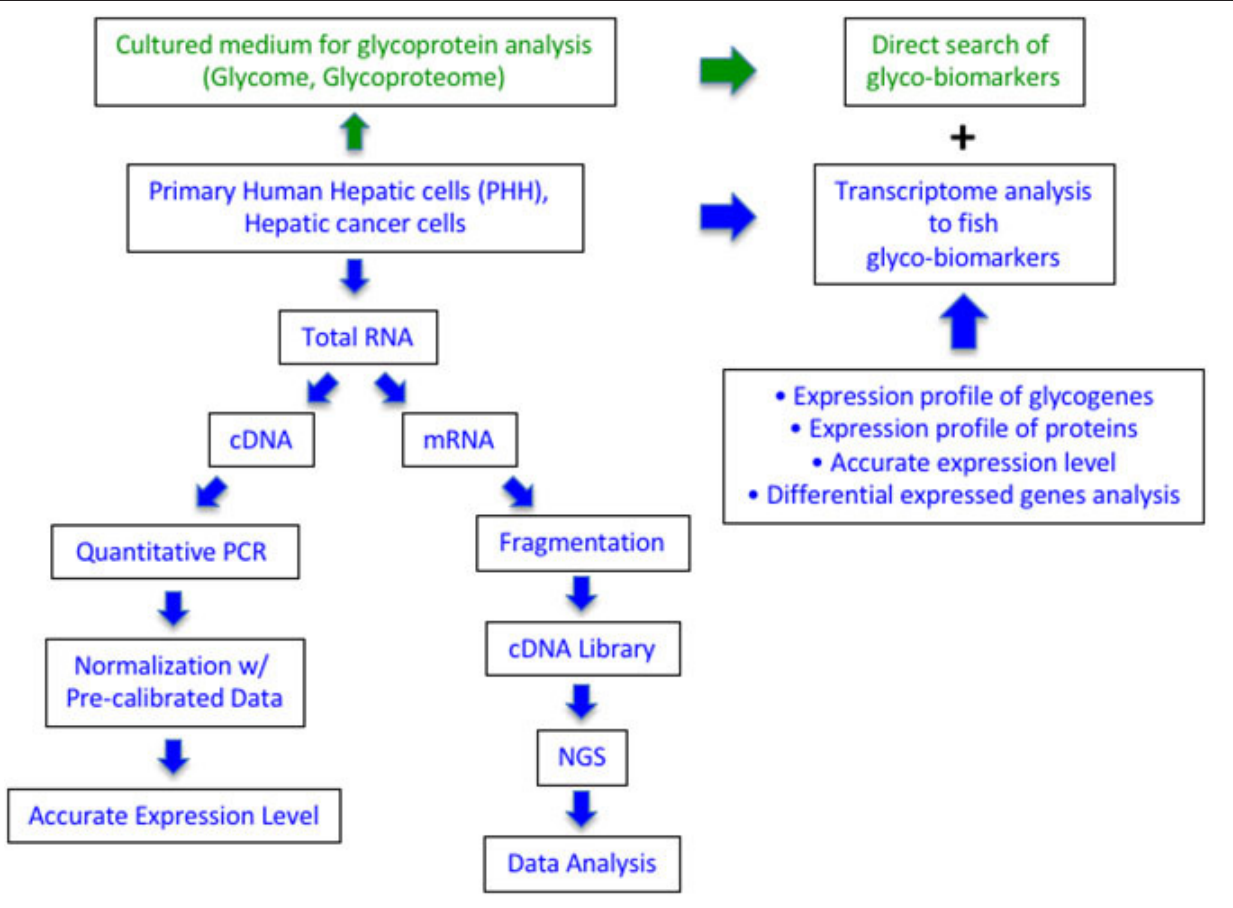
FIGURE 1 | Comparison of qRT-PCR array and RNA-Seq in expression analysis of glycogenes to search for glyco-biomarker. The green part is the current glycome and glycoproteome analysis using cultured media of cancer cells. The blue part is described in this study using RNA from the cultured cells. Quantitative PCR can measure the expression level as the copy number of 186 glycogenes, while RNA-Seq can collect the expression profile of all protein genes including glycogenes.